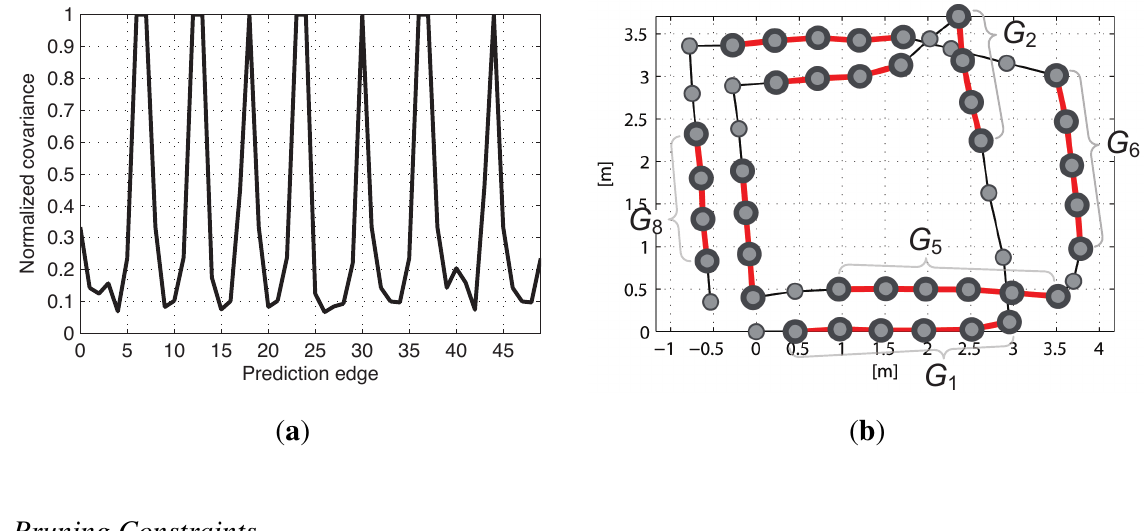
Figure 11. ( a ) Normalized covariance values of the prediction edges; ( b ) Result obtained after grouping the nodes. The red and bold lines represent the grouped nodes. In this case, eight groups are formed, G to G 1 8